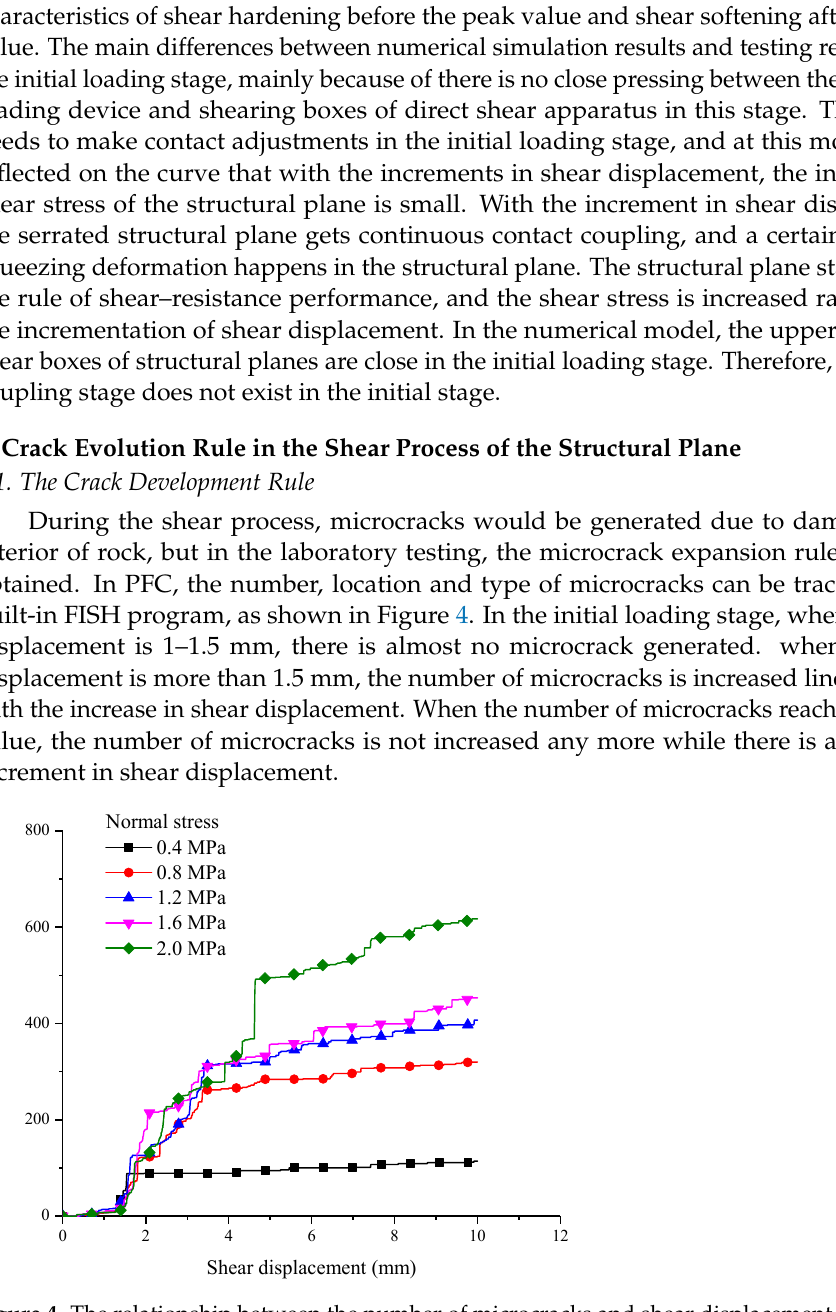
Table 2. Shear mechanical parameters under test and simulation conditions.